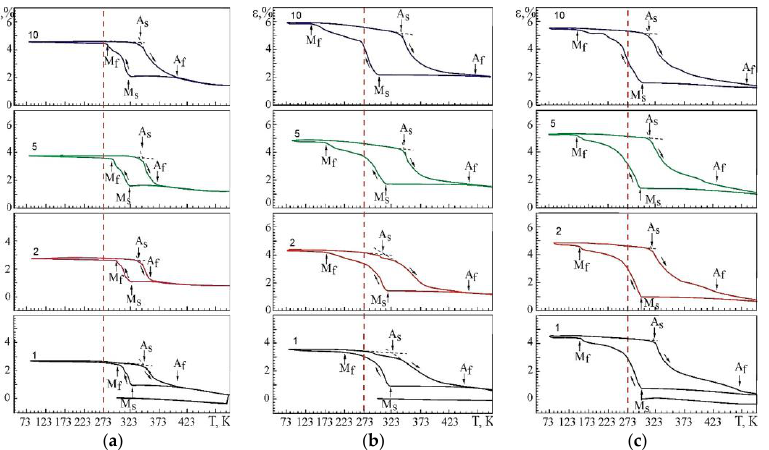
Figure 11. Multiple SME in alloys: ( a ) No. 1; ( b ) No. 2; ( c ) No. 3. The numbers indicate the numbers of cycles after thermal cycling through the MT region.